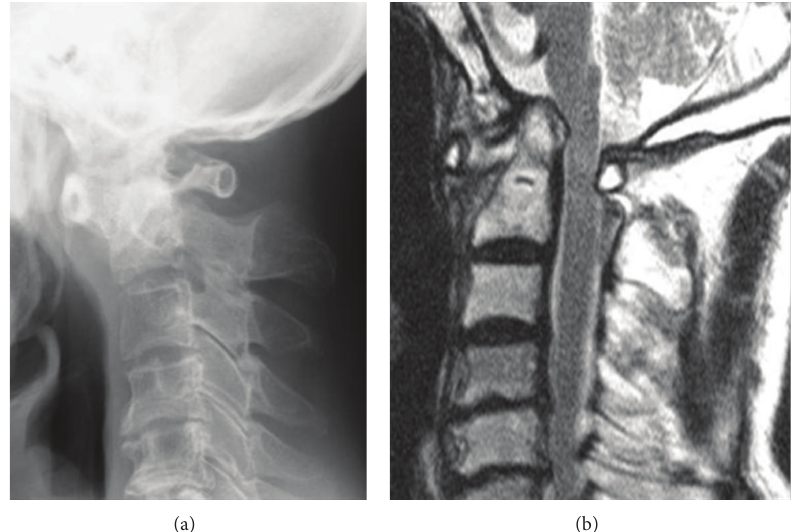
Figure 4: Images six months after the treatment of intravenous antibiotics and a halo immobilization showing vertical subluxation on the odontoideum and disappearance of the abscess. (a) Lateral view. (b) Sagittal T2-weighted